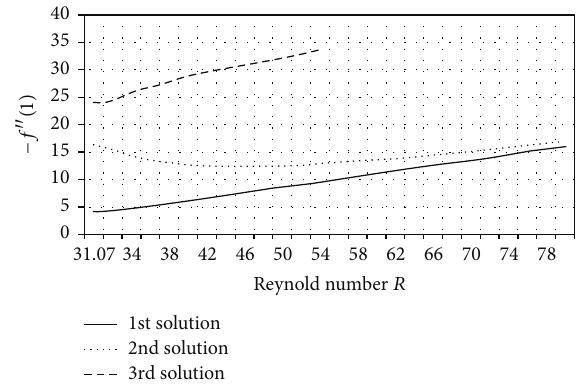
Figure1:Skin friction −𝑓 󸀠󸀠 (1) againstthevalues ofReynold number 𝑅